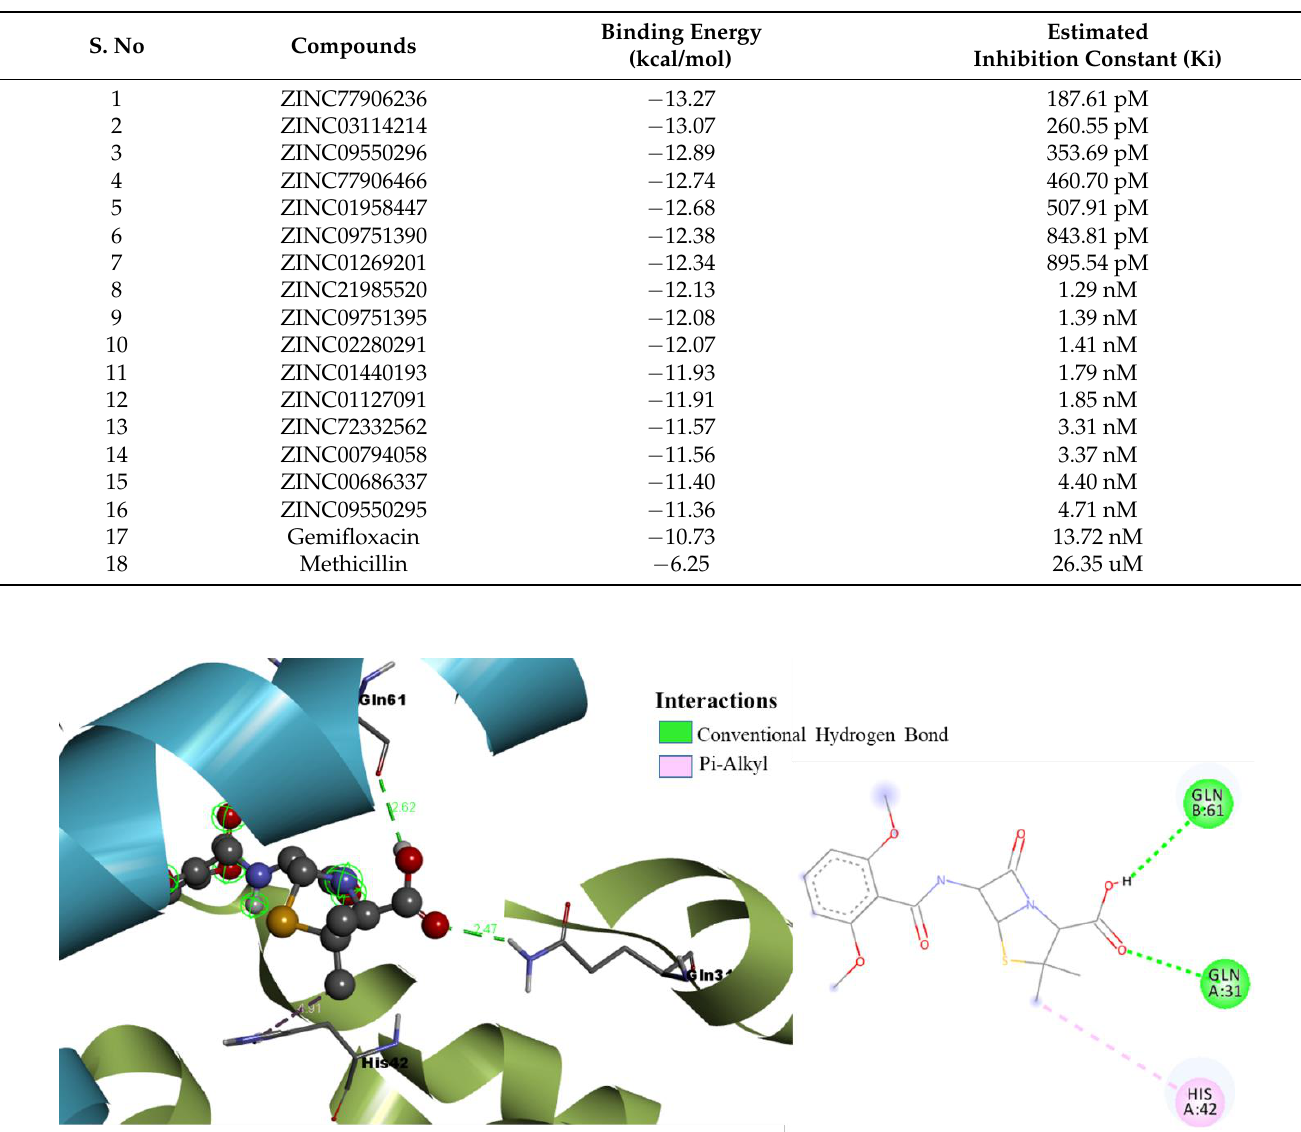
Table 1. Binding energies and estimated inhibition constants of hit compounds identified from pharmacophore-based virtual screening. Methicillin is a known crystallographic inhibitor of S. epidermidis TcaR.